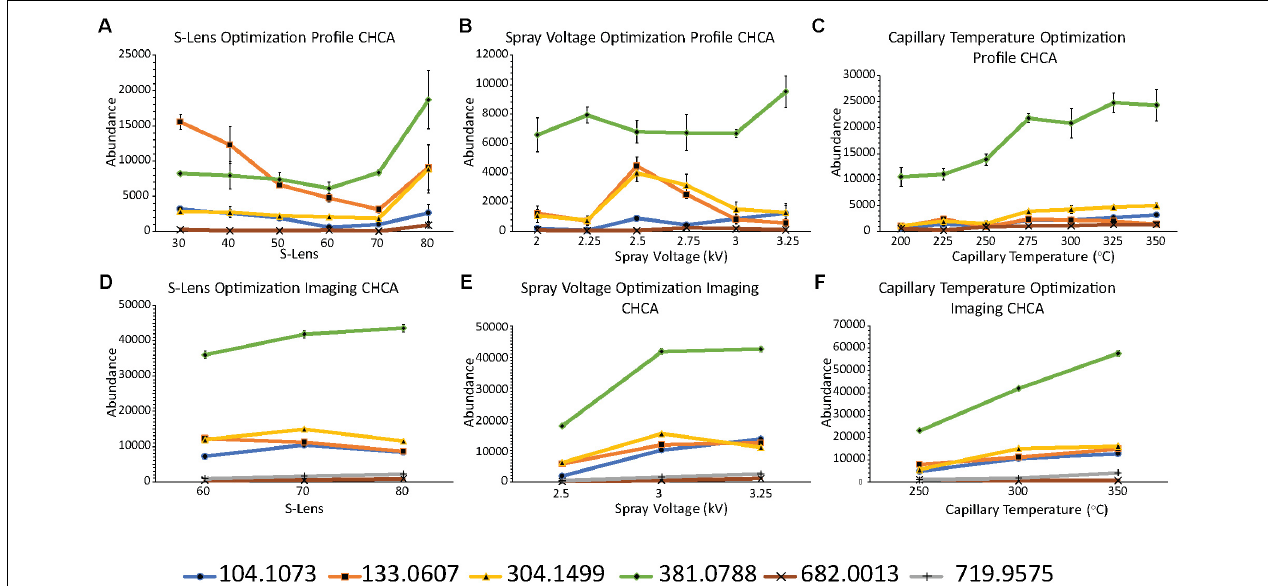
FIGURE 1 | QE-HF parameter optimization graphs with CHCA as the matrix. (A–C) Show optimization of S-lens (A) , spray voltage (B) , and capillary temperature (C) by profiling on tissue. (D–F) Show optimization of S-lens (D) , spray voltage (E) , and capillary temperature (F) by imaging individual control nodules. Different m/z values are indicated by line color and data point shape. Error bars indicate standard error of the mean.